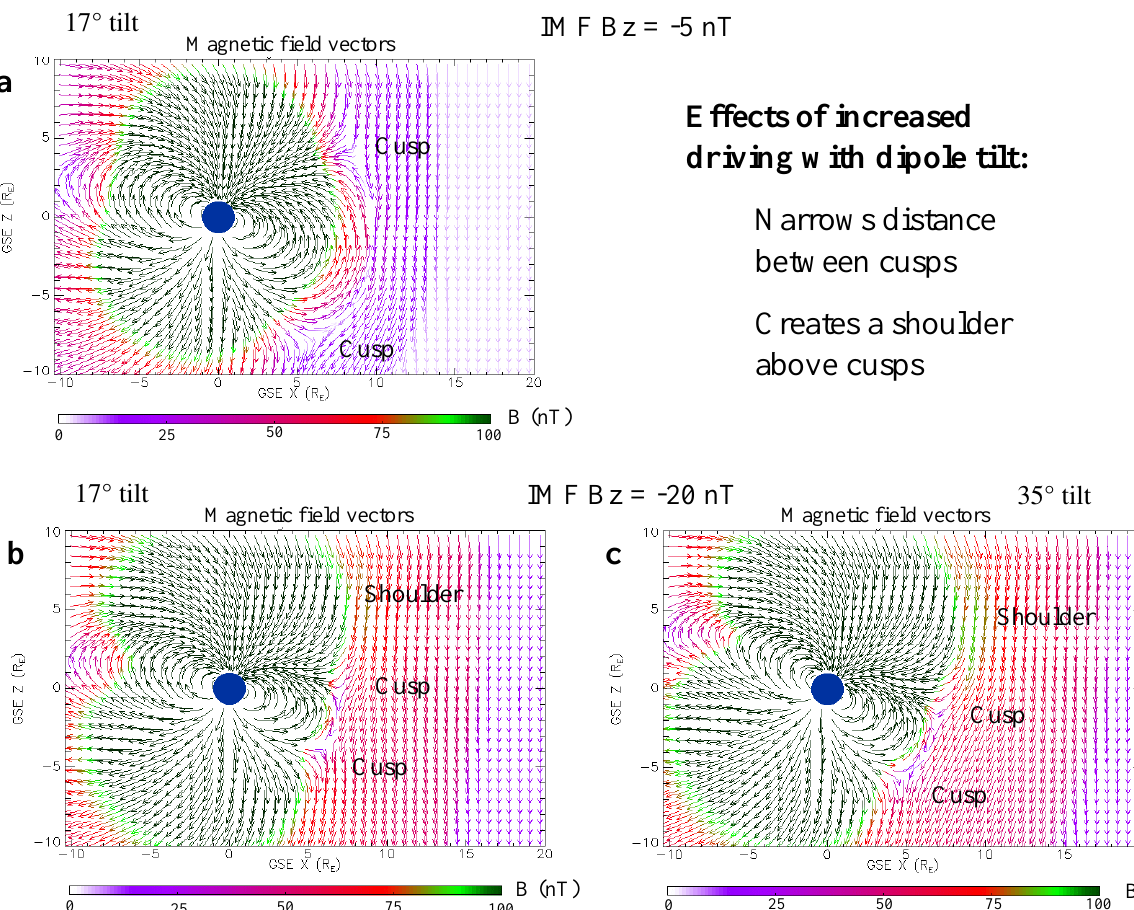
Fig. 6. Simulation of the effects of increased dipole tilt and increased magnitude of the IMF. All panels show the XZ plane at Y = 0. The arrows show the direction of the magnetic field and are colored with the magnitude. (a) and (b) have the same dipole tilt but change the IMF driver. (b) and (c) have the same input driver, but change the dipole tilt. Note that the increased IMF driver compresses the cusps together and starts to build a shoulder of enhanced magnetic field above the cusp that is tilted toward the Sun. Increasing the dipole tilt increases the size and strength of the